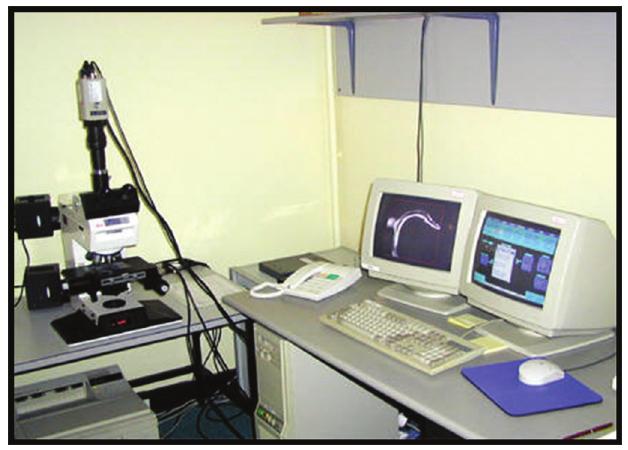
Figure 4. Equipment used for area morphometric studies.